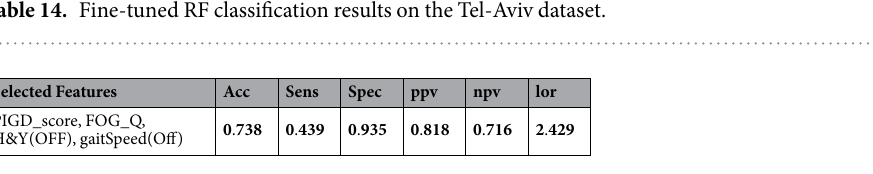
Table 15. Logit model prediction of falls in the Tel-Aviv case, using only four features.